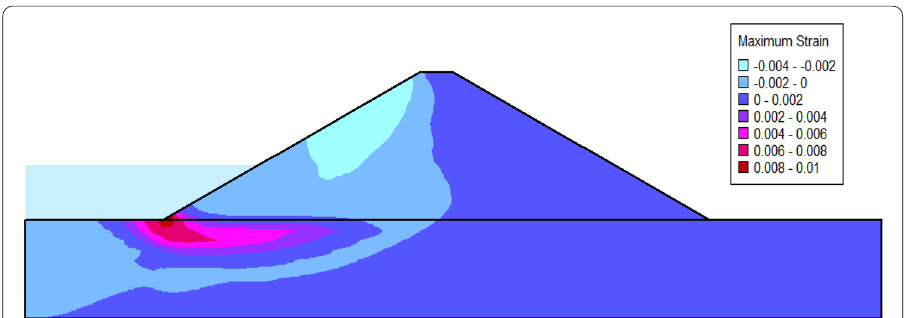
Fig. 27 Maximum strain contours within the earthen dam upon partial drawdown of the reservoir on the 68th day